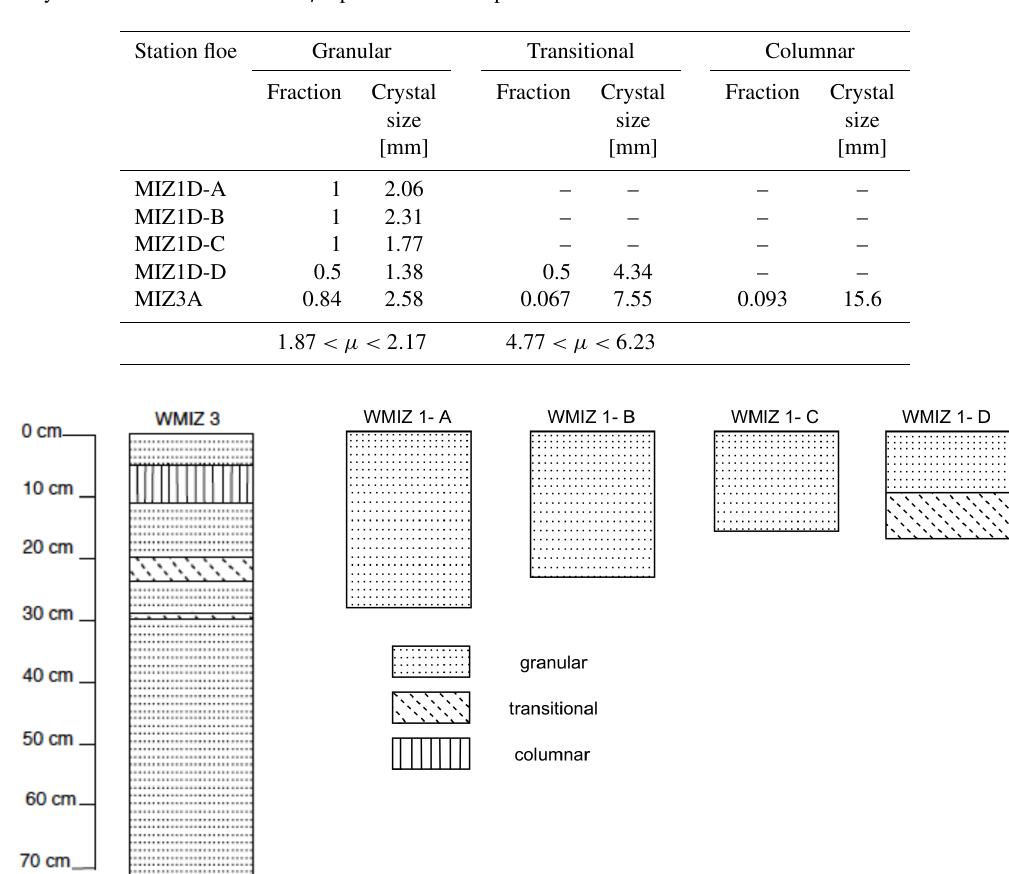
Table 4. Summary of the sea ice core textures. µ specifies the 95th-percentile confidence intervals.